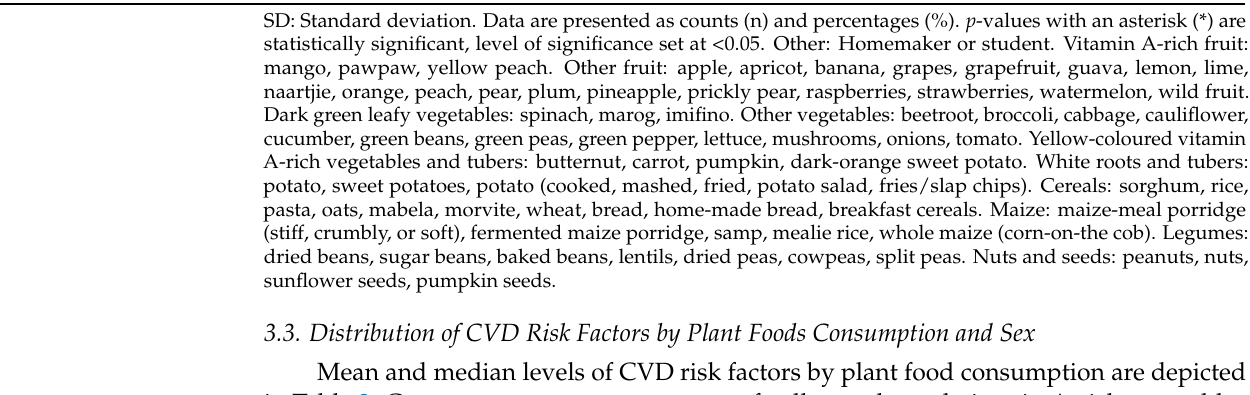
in Table 3. Consumers vs. non-consumers of yellow-coloured vitamin A-rich